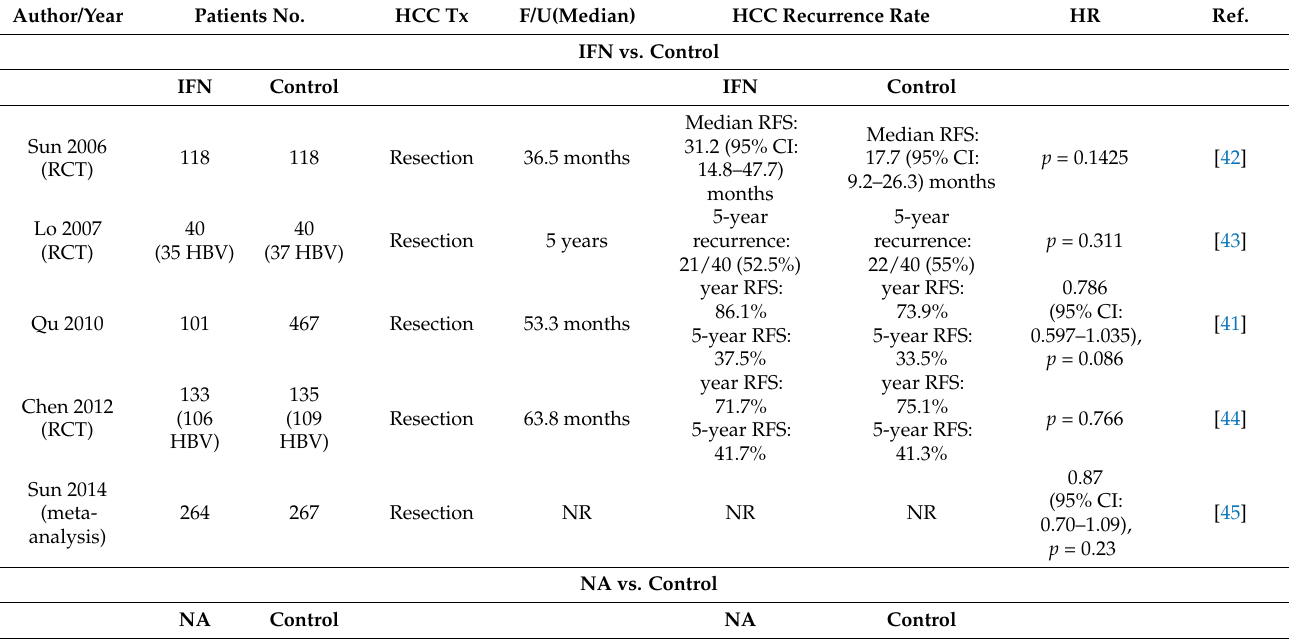
Table 1. Characteristics of large-scale studies reporting hepatitis B virus (HBV)-related HCC recurrence rates after anti-viral